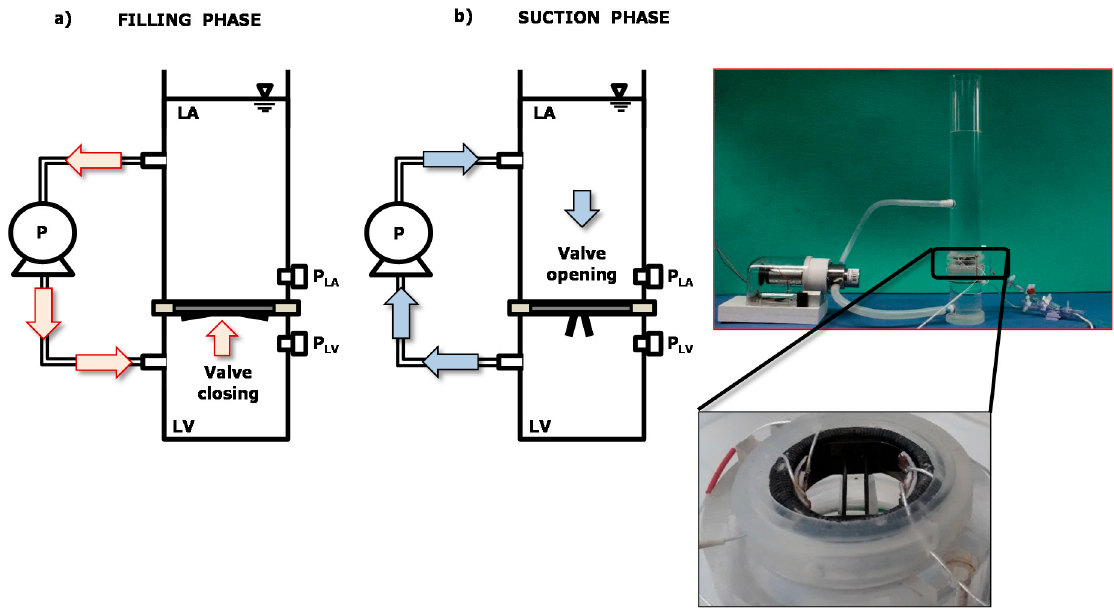
Figure 3. Scheme and picture of the mock loop system: ( a ) Filling phase that causes valve closing; ( b ) suction phase that causes valve opening. P = pump; LA = Left Atrium; LV = Left Ventricle; P LA = LA pressure; P LV = LV pressure.